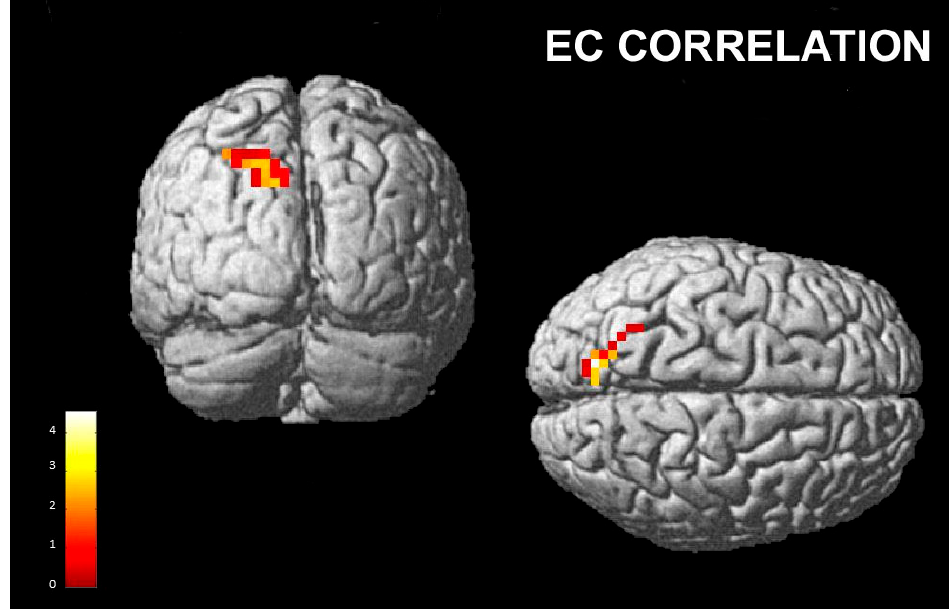
Figure 4. EC correlation for the contrast “posing happiness and perceiving happiness” vs. “posing happiness and perceiving disgust”; cluster size threshold k > 30, corrected at α < 0.05. Same overlay procedure as in Figure 3.